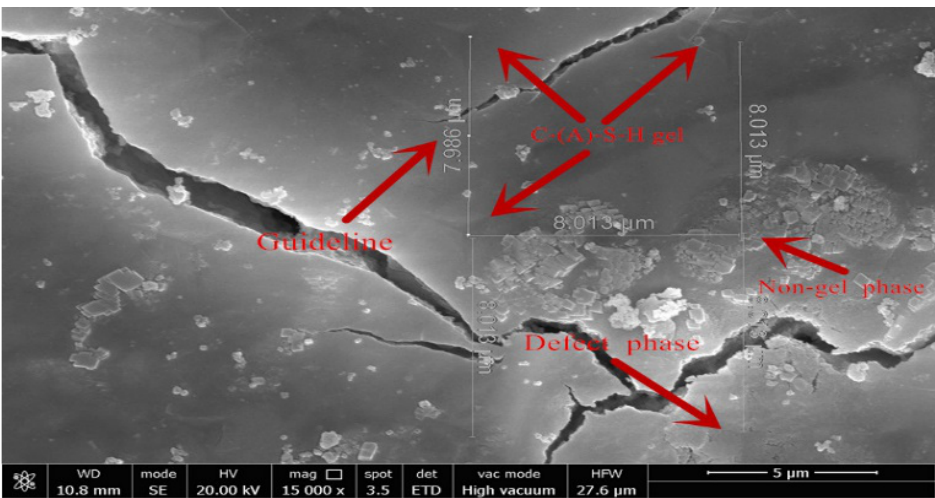
Figure 9. Nanoindentation morphology of sample CMH106 by SEM.